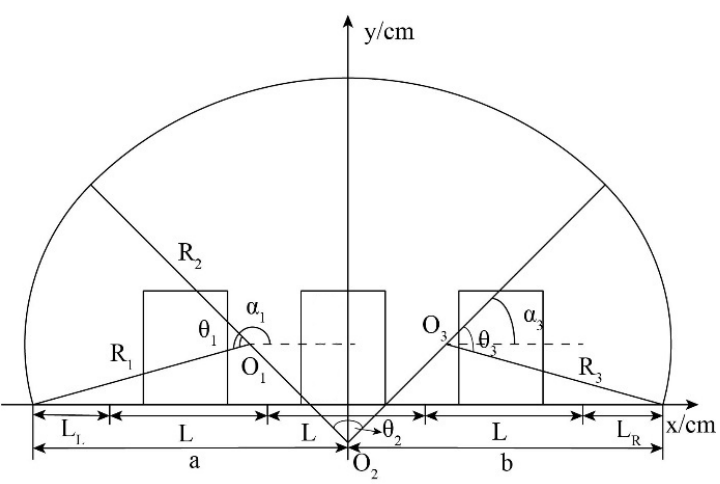
Figure 6. Camera attitude control model coordinate system.